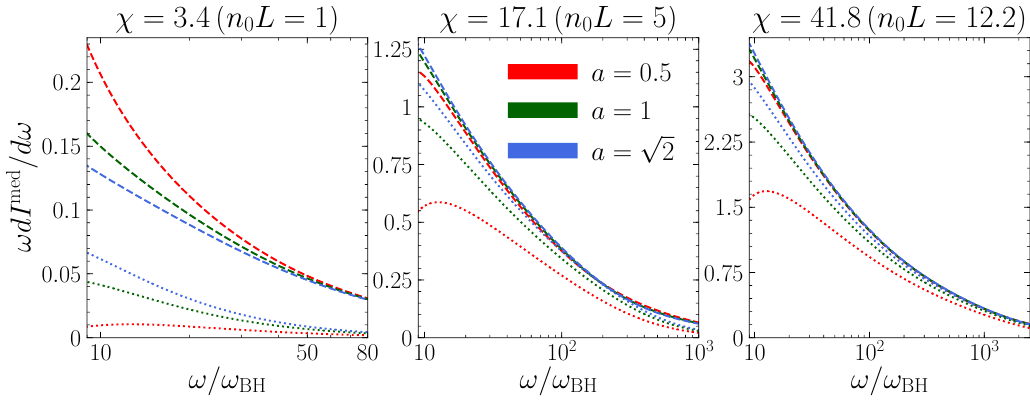
Figure 2 . Left panel: HO (dotted lines) and HO+NLO (dashed lines) contributions to the gluon energy distribution for χ = 3 . 4 (or n 0 L = 1 ) as a function of ˆ x = ω/ω BH for different values of the matching scale Q 2 = a Q 2 . Central and right panels: same as left panel for χ = 17 . 1 (or n 0 L = 5 ) c and χ = 41 . 8 (or n 0 L = 12 . 2 ),